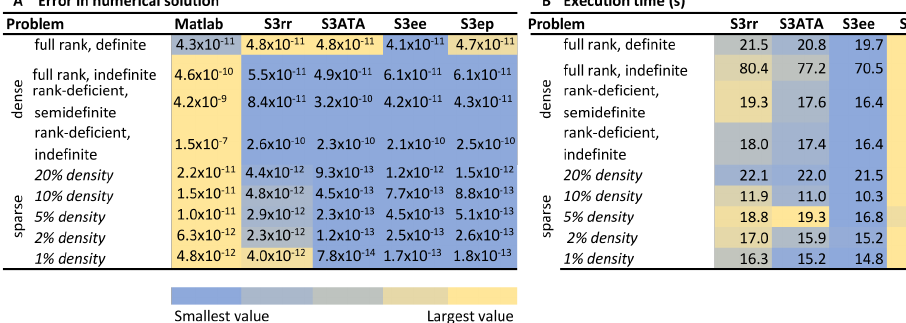
Figure 5. Numerical properties of the four ABS-based variants and Matlab algorithm for solving 1500-dimensional random systems of equations. Panel ( A ) shows the computational accuracy. Panel ( B ) shows the execution times for our ABS-based variants in seconds. Note that the execution times of Matlab algorithms are not presented, since the Matlab built-in functions are implemented in C, which allows the algorithms to run significantly faster than our programs written in Matlab script regardless of the actual numerical performance of the